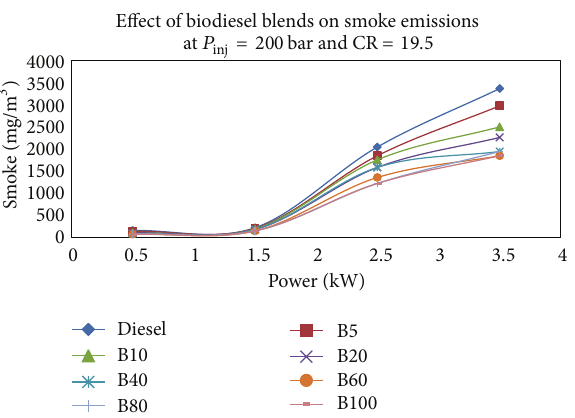
Figure 17: Variation in NO 𝑥 for various biodiesel blends at 𝑃 180 bar and CR 19.5.